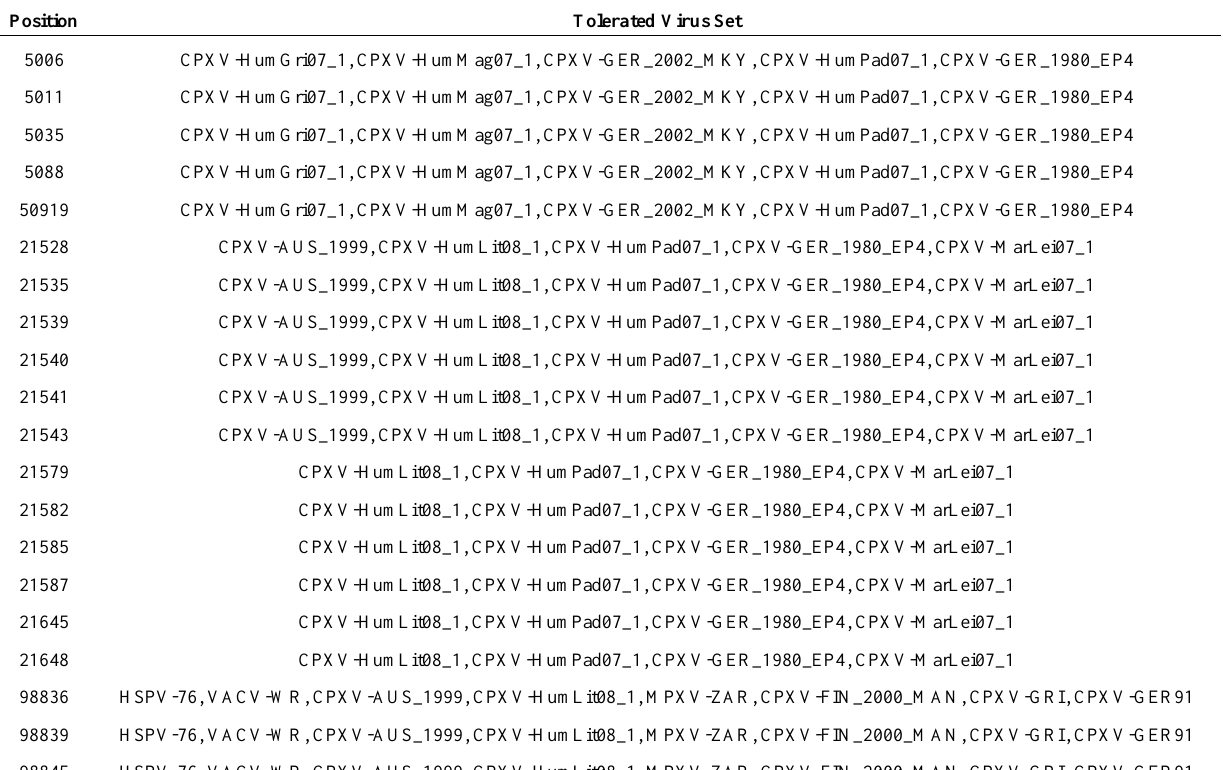
Table 5. Positions where all four viruses of the VARV clade are the same and all others are different, except the set of viruses